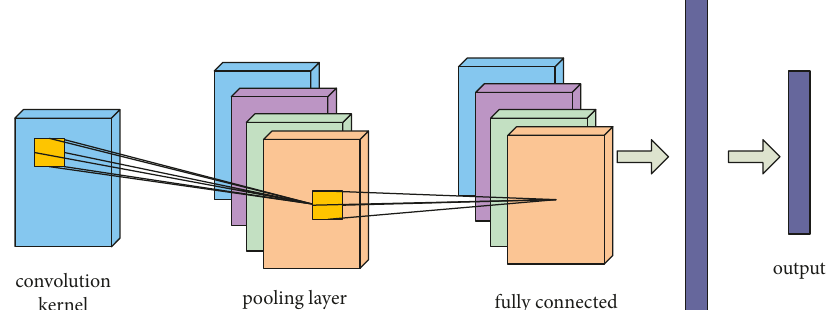
Figure 2: Basic structure of convolutional neural